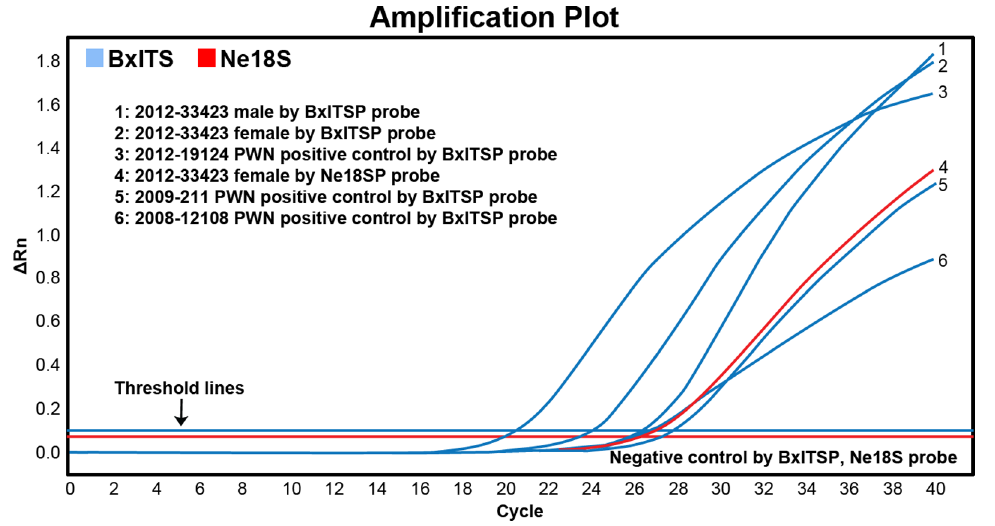
Figure 4. Example of a real-time-PCR result for testing sample 2013–33423 by PWN-specific- and nematode-universal- primer/ probes.